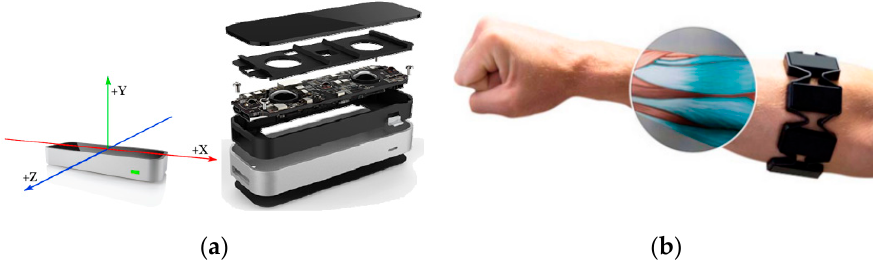
Figure 5. Leap Motion controller ( a ) and Myo armband ( b ). [9].